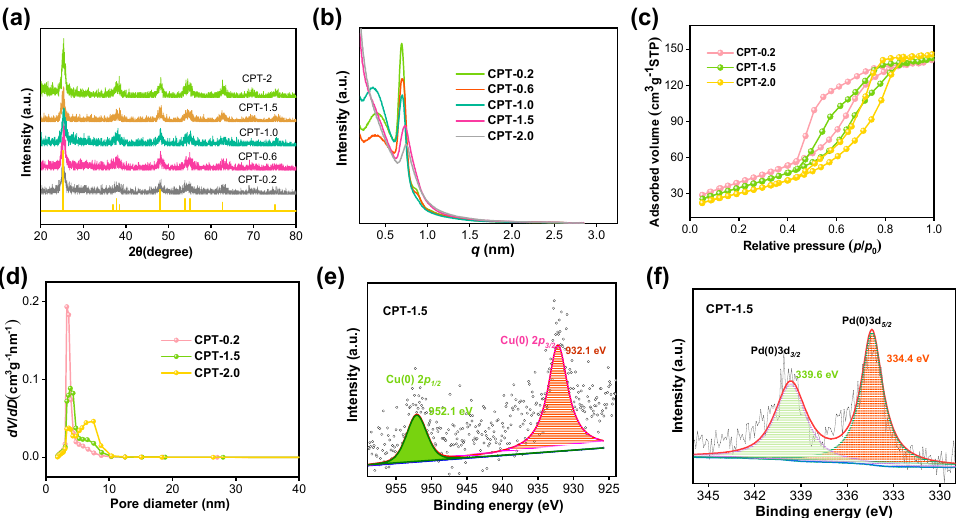
Figure 2. Structural analysis of CPT-X. ( a ) wide-angle ( b ) SAXS patterns of CPT with different Cu/Pt ratio, ( c ) N 2 sorption isotherms, ( d ) pore-size distribution curves of CPT-0.2, CPT-1.5, and CPT-2.0, ( e ) Cu 2p, and ( f ) Pd 3d XPS spectra of CPT-1.5.